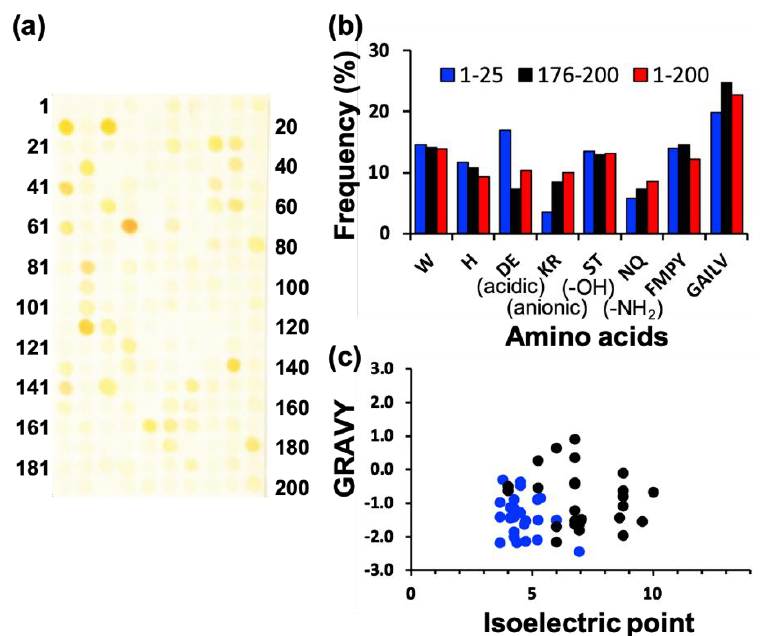
Figure 1. Screening of silver nanoparticle (AgNP) mineralization peptides using peptide array consisting of AuNP-binding peptides. (a) Representative image of peptide array after biomineralization reaction by soaking in AgNO 3 -containing solution for 7 h. (b) Amino acid frequencies for high-mineralization peptides (TOP25) and low-mineralization peptides (WORST25), based on the brightness evaluation from each peptide spot using ImageJ. (c) Physicochemical properties of high- and low-mineralization peptides. Physicochemical properties of high-binding TOP25 peptides (blue circle) and worse binding WORST25 peptides (black circle), based on pI and GRAVY (the grand average of hydropathy) values. The latter is considered the average hydropathy value for all amino acids in a peptide sequence; therefore, high GRAVY values denote hydrophobicity.